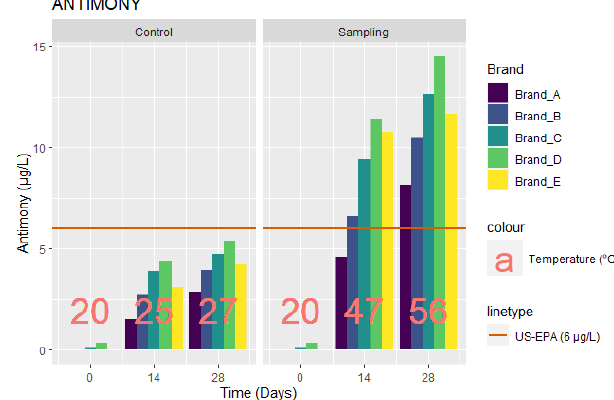
Figure 2. Antimony values for the control group and sunlight ex- posure